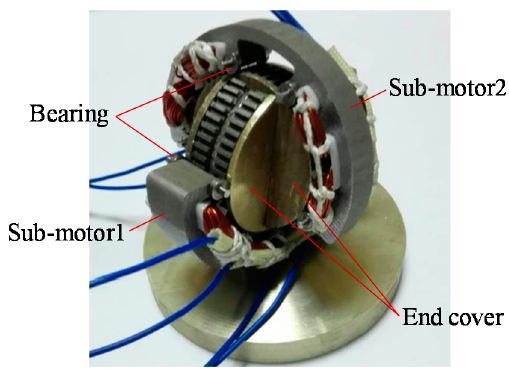
Figure 7. Prototype of the developed spherical 2-DOF hybrid stepping motor. Table 1. The same parameters of sub-motor1 and sub-motor2.